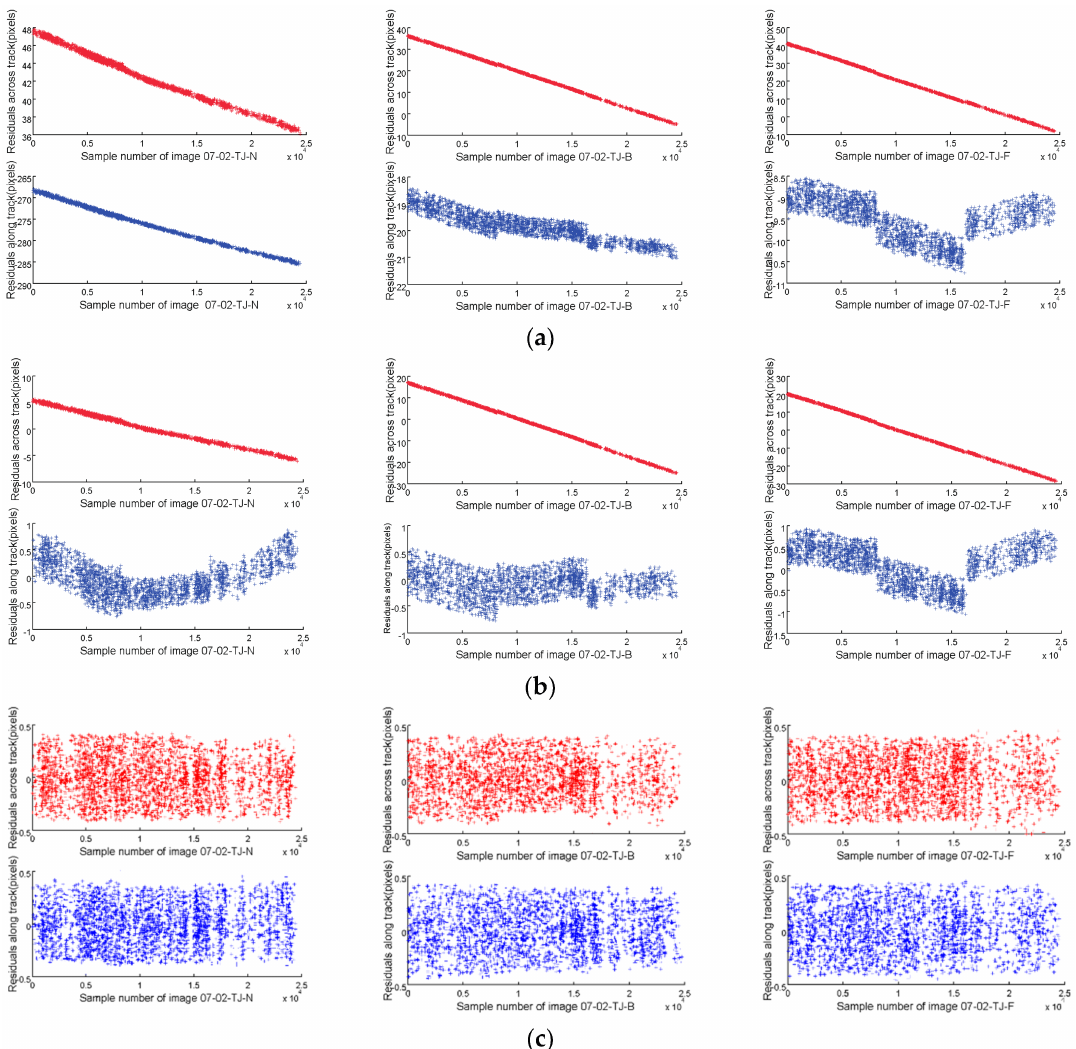
Figure 9. ( a – c ) Residual errors of images 07-02-TJ-N/07-02-TJ-B/07-02-TJ-F (here ( a – c ) correspond to ( a – c ) in Table 4).